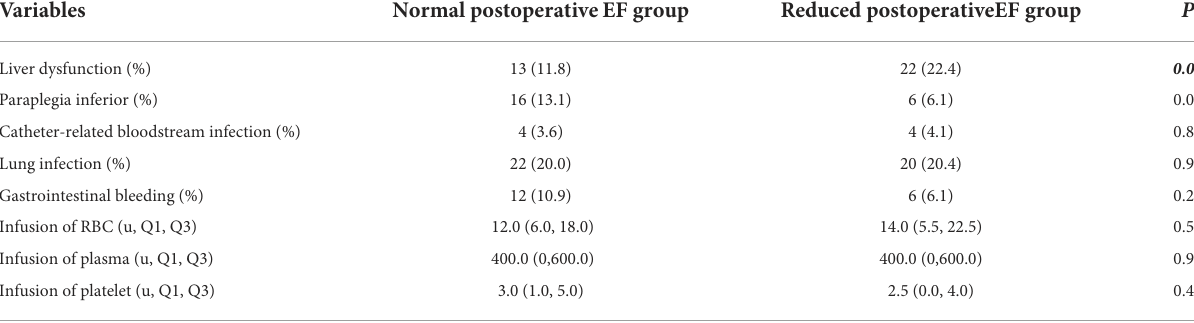
TABLE 4 Comparison of postoperative complications and transfusion data during ICU between the normal postoperative EF group and the reduced postoperative EF group.